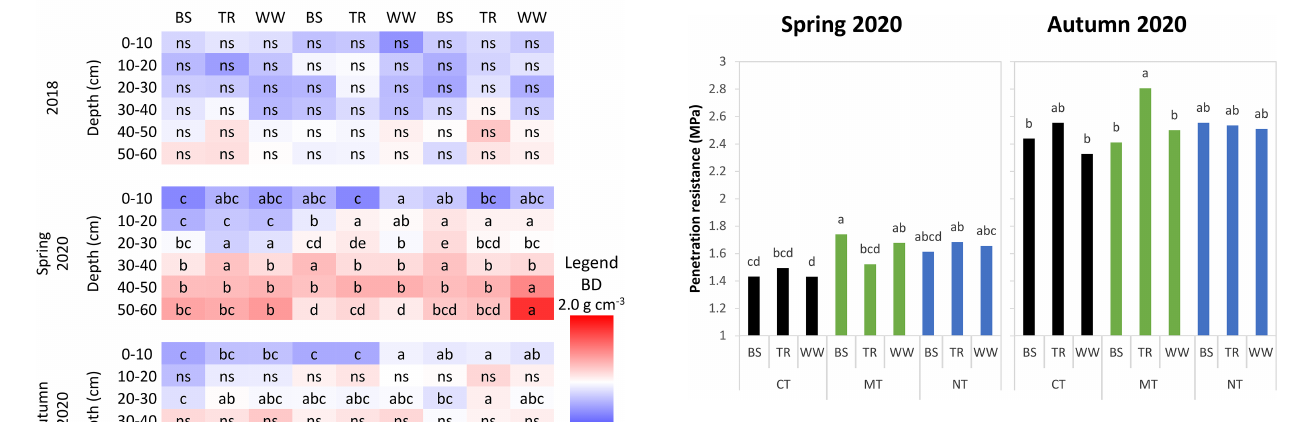
Figure 4. Penetration resistance along the 0–60cm soil profile. Different letters represent significant differences according to the post hoc Tukey test with p < 0 . 05. Note: CT – conventional tillage; MT – minimum tillage; NT – no tillage; BS – bare soil; TR – tillage radish; WW – winter wheat.